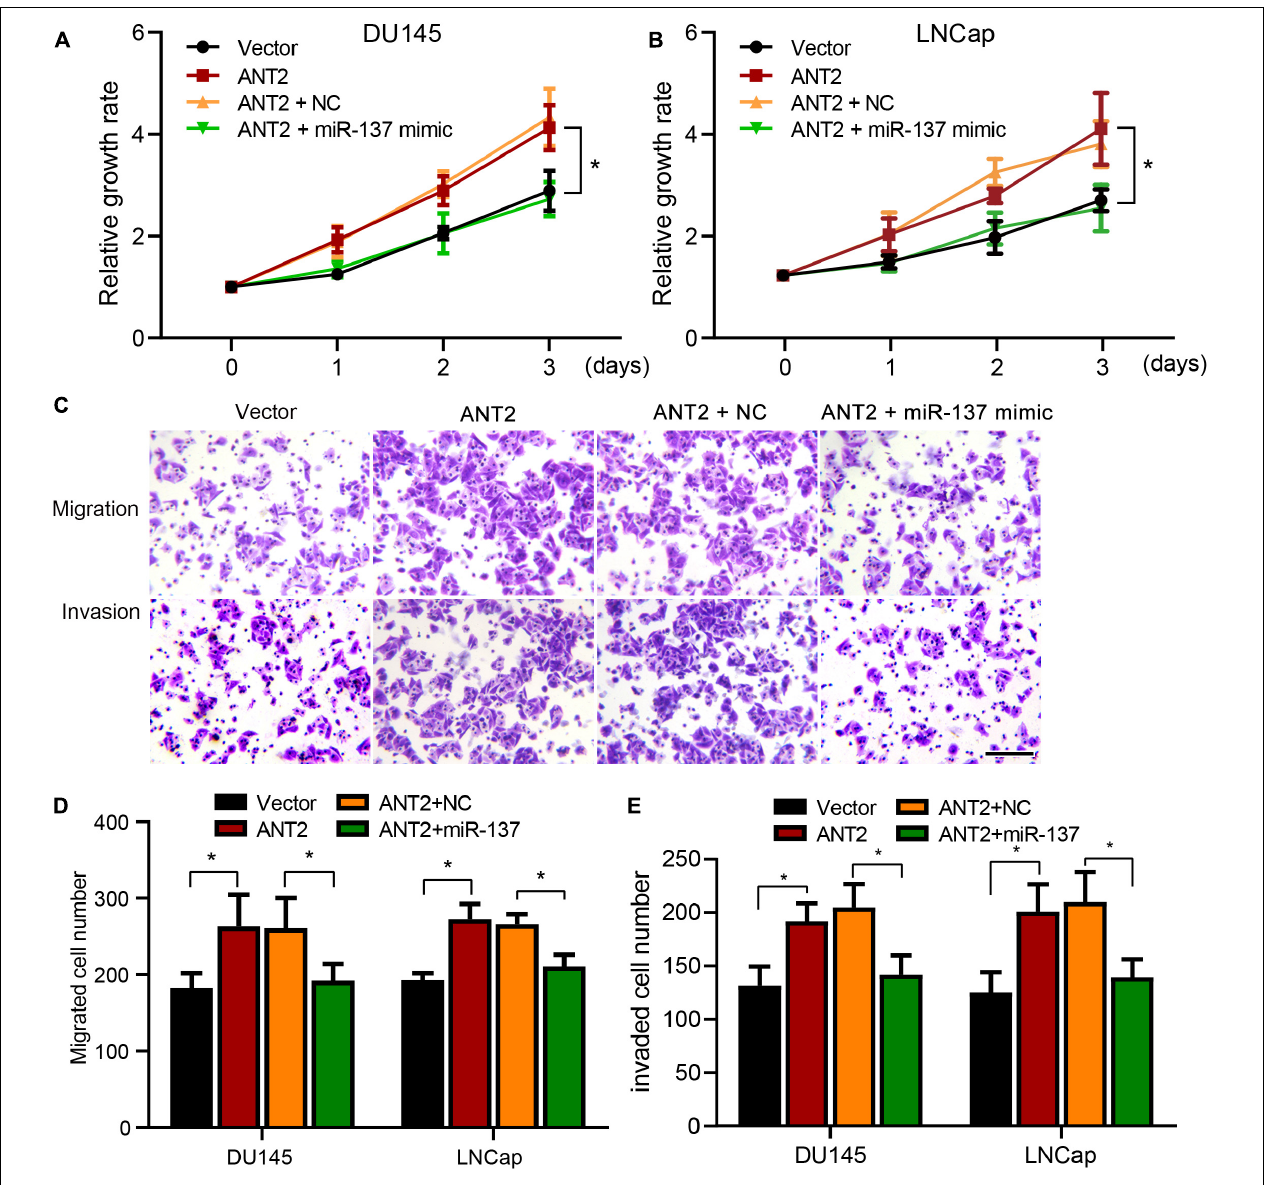
FIGURE 5 | miR-137 regulates prostate cancer cells by inhibiting ANT2. (A,B) After treatment with miR-137 mimics + ANT2 treatment, proliferation of LNCaP and DU145 cells decreased. (C) Migration and invasion of LNCaP and DU145 cells were attenuated after treatment with miR-137 mimics + ANT2. Scale bar, 50 µ m. (D,E) Migration and invasion of LNCaP and DU145 cells were increased after ANT2 overexpression but attenuated after miR-137 interference. * p <